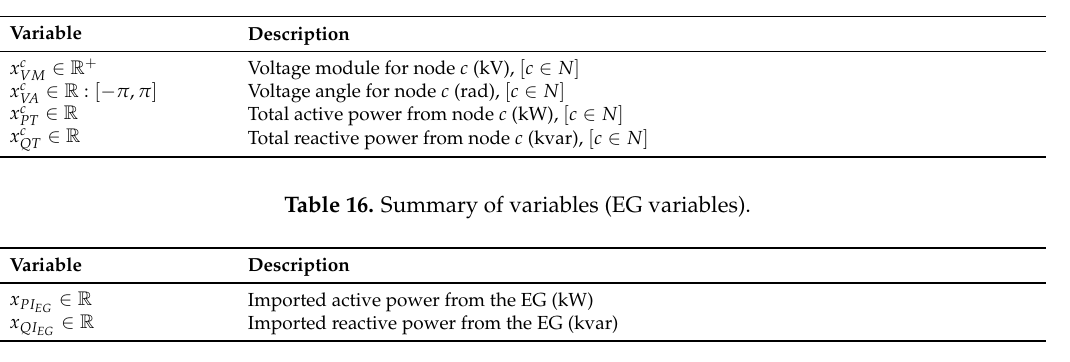
Table 15. Summary of variables (voltage and total power variables).